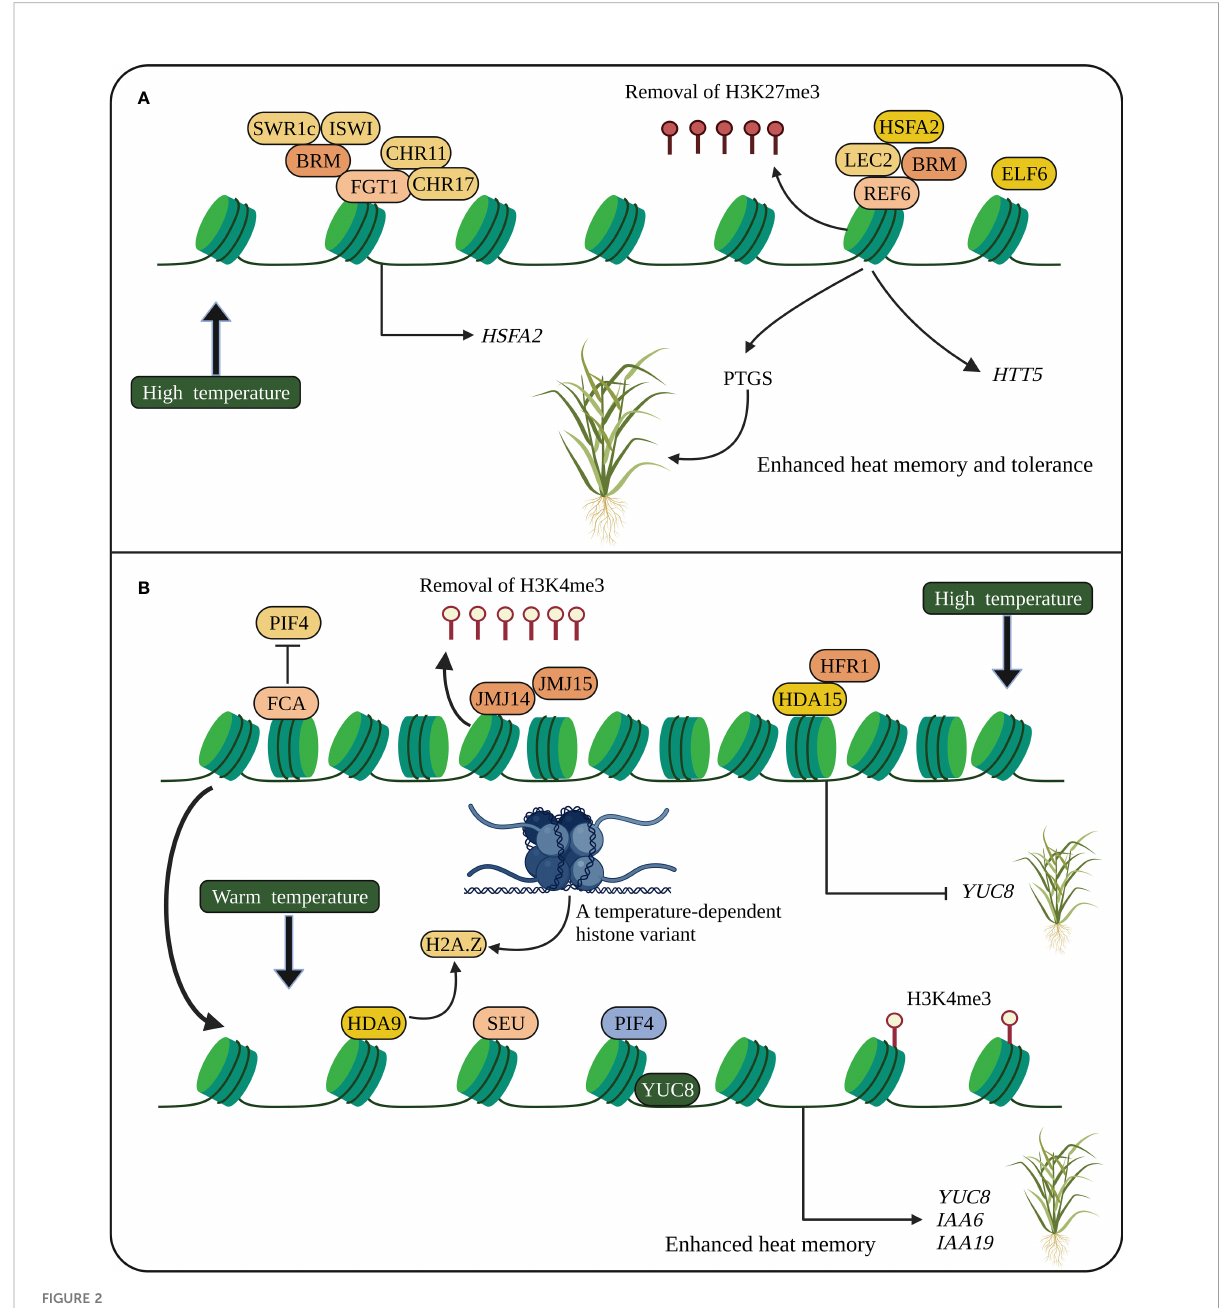
FIGURE 2 Heat stress memory in plants. (A) Heat memory is regulated by HSFA2-REF6-PTGS and FGT1. HSFA2 and REF6 are essential for heat memory and trigger the SGS3-interacting protein, which degrades SGS3 and inhibits PTGS. REF6 removes H3K27me3, and FGT1 and the chromatin remodelers such as BRM, CHR11 and CHR17 modulate nucleosome occupancy at the loci of heat memory genes. (B) Stress memory (thermomorphogenesis) is also regulated by PIF4. Epigenetic modi fi cations and chromatin remodelers activate PIF4 to promote stress memory genes. A temperature-dependent histone variant (H2A.Z) modulating gene network is associated with YUC8 to promote PIF4 activation. HSFA2, heat shock transcription factor; REF6 , RELATIVE OF EARLY FLOWERING 6 ; PTGS, posttranscriptional gene silencing; SGS3 , SUPPRESSOR OF GENE SILENCING 3 ; FGT1 , FORGETTER1 ; BRM, BRAHMA; CHR11 and CHR17, CHROMATIN-REMODELING PROTEIN 11 and 17, respectively; JMJC14 and JMJC15, Jumonji C domain-containing protein 14 and 15, respectively; PIF4 , PHYTOCHROME INTERACTING FACTOR 4 ; FCA , FLOWERING CONTROL LOCUS A ; SEU , SEUSS ; YUC8 , YUCCC8 ; IAA , INDOLE-3-ACETIC ACID INDUCIBLE . The schematic representation was adapted from (Xie et al., 2021) by adding additional information and created using